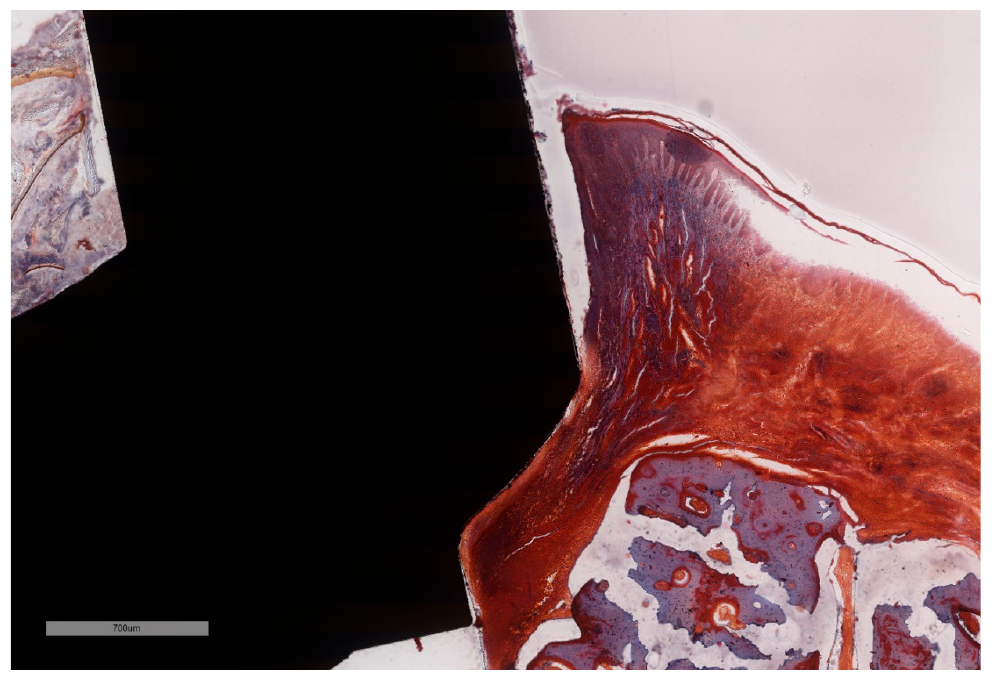
Figure 9. Despite the presence of intense inflammation induced by the ligature, the deep peri-im- plant sulcus presents a continuous epithelial lining. The intimate contact between the soft tissues and the implant is below the BC level (implant #5, MGA, bar measure is 2 mm).